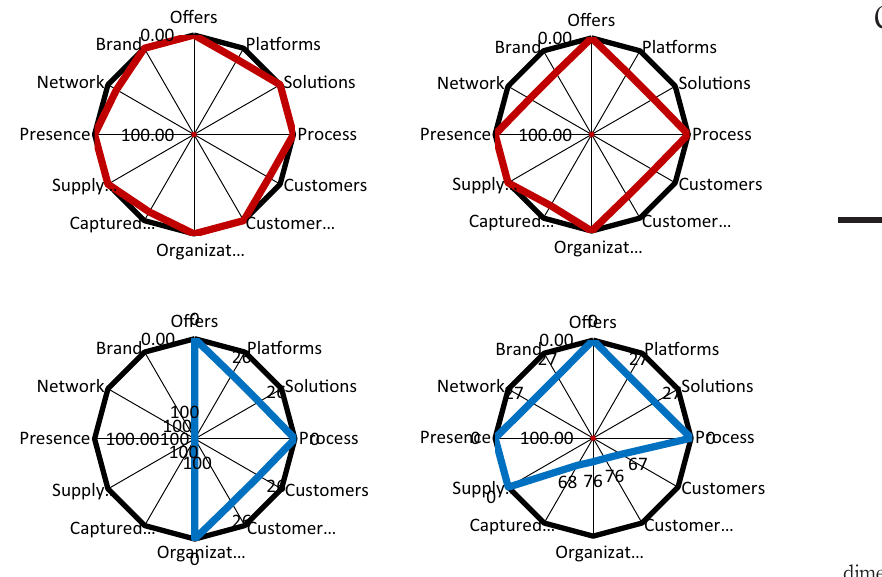
Figure 1. A comparison between the IR dimensions and other